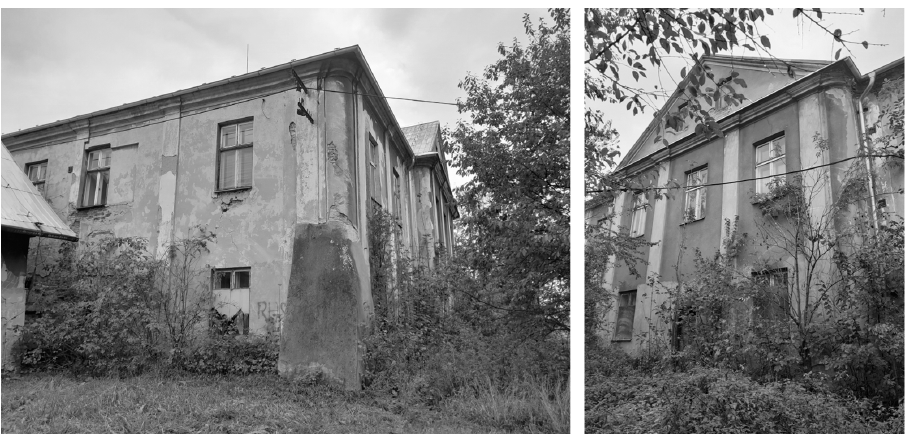
Figure 1. Chateau brownfield in Doubrava, Moravian ‐ Silesian Region, Czech Republic (2022).